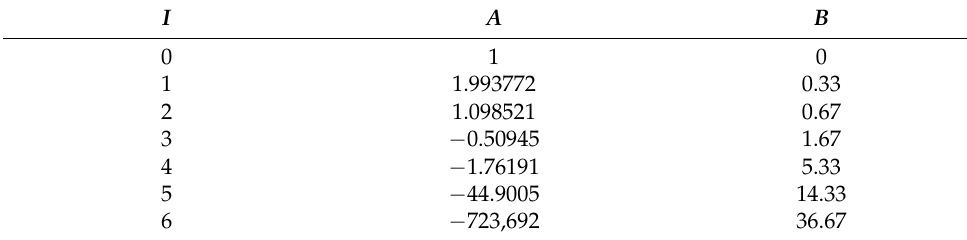
Table A3. Parameters A i and b i for Equation (A32) for H 2 O.